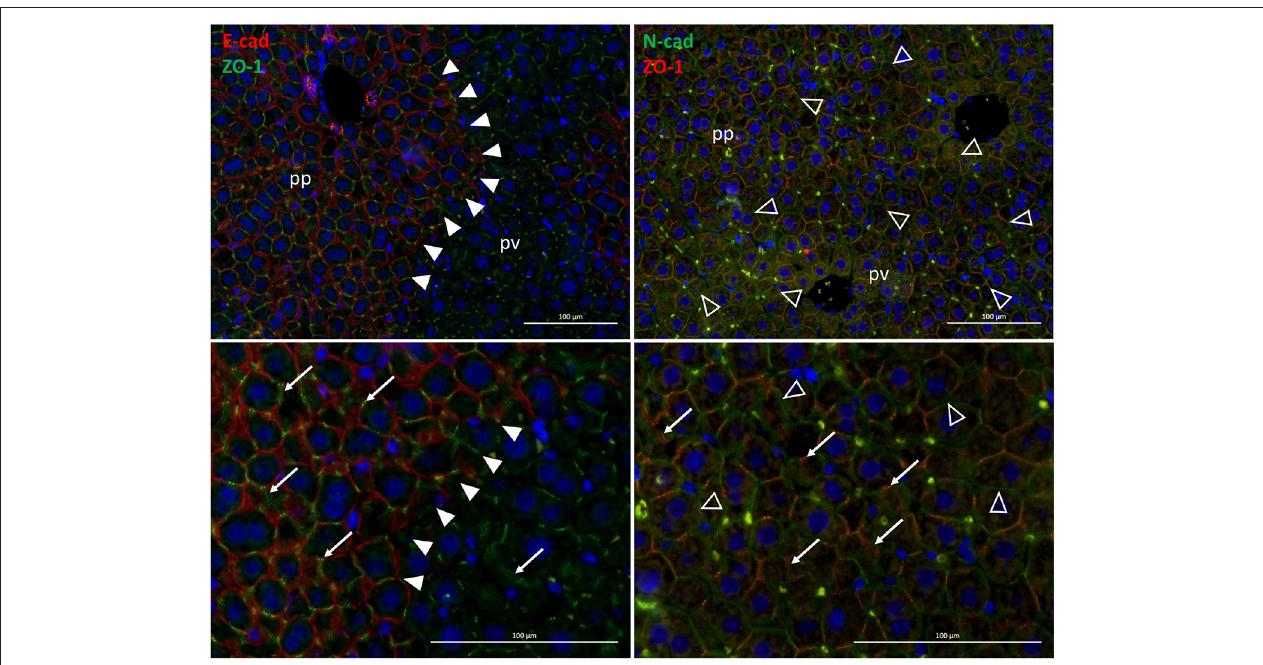
FIGURE 2 | Zonal expression of E-cadherin (red, left panels)and of N-cadherin (green, right panels) in mouse liver sections. The exclusive periportal expression of E-cadherin demarcates the boundary between periportal and perivenous hepatocytes in the liver lobule (solid arrowheads). In contrast, N-cadherin is expressed all over the hepatic parenchyma (open arrowheads). Also, the tight junction protein ZO-1 (green, left panels; red, right panels) designating the bile canaliculi (white arrows) is expressed pan-parenchymally. Lower panels are digital magnifications of images shown in the upper panels. pp, periportal; pv,